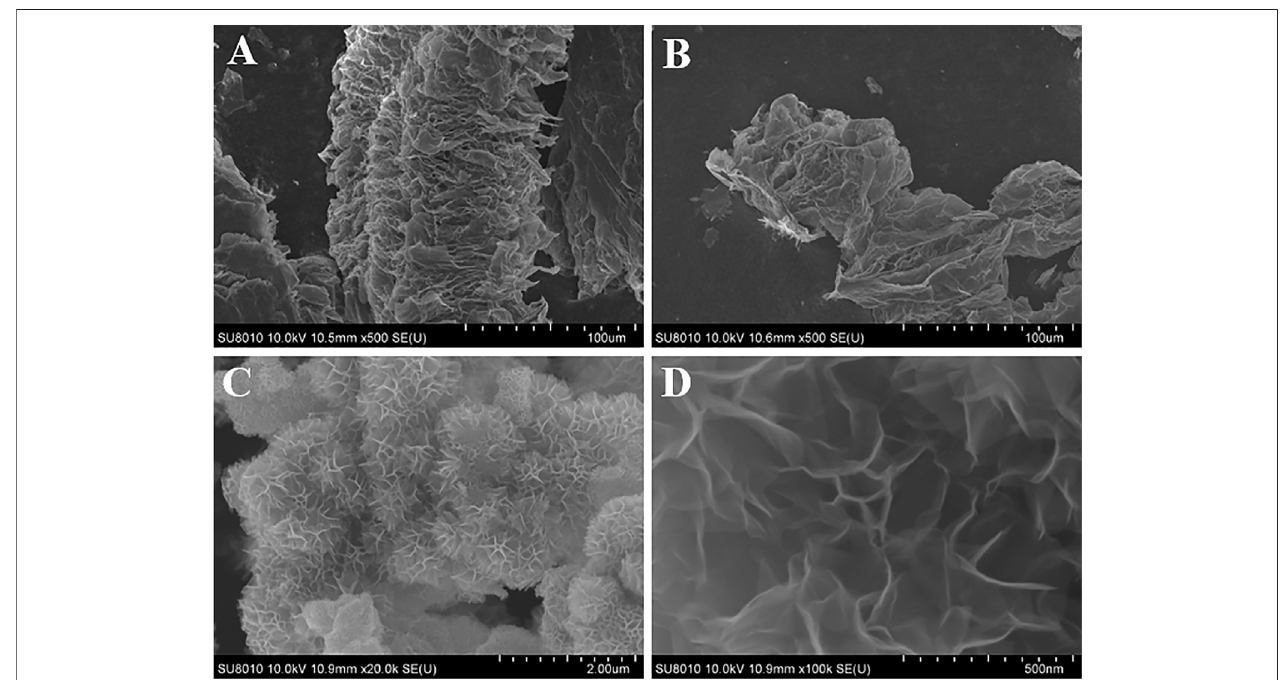
FIGURE 3 | The microstructure of TE-G-H 2 O (A) , TE-G-KCl (B) , and MnO 2 /rGO composites (C,D) .